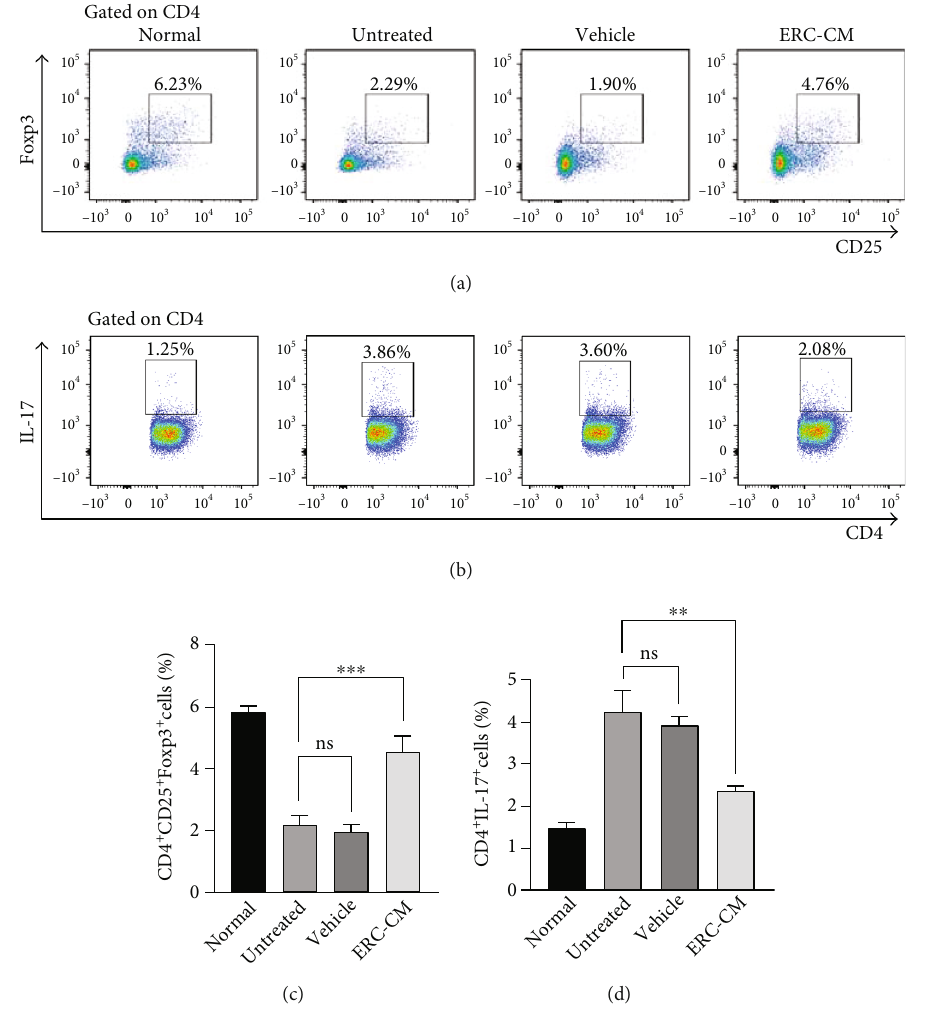
Figure 5: ERC-CM decreased the percentage of Th17 cells but increased the percentage of Tregs in the colon. Representative dot plots of CD4 + CD25 + Foxp3 + Tregs (a), CD4 + IL-17 + Th17 cells (b) in the lamina propria. Percentage of CD4 + CD25 + Foxp3 + Tregs (c) and CD4 + IL- 17 + Th17 cells (d). Data shown were representative, and the p value was determined by one-way ANOVA. ∗ p < 0 : 05 , ∗∗ p < 0 : 01 , ∗∗∗ p < 0 : 001 , and ∗∗∗∗ p < 0 : 0001